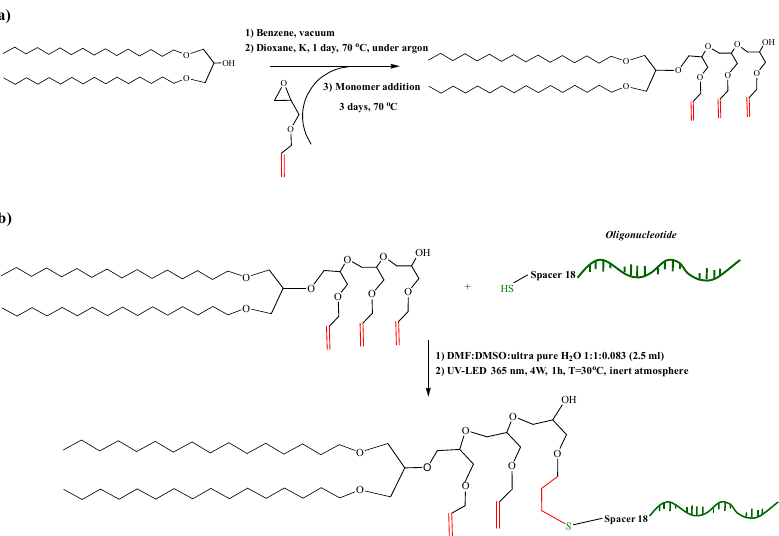
Figure 1. Synthetic schemes for preparation of ( a ) the DHP - (AGE) n intermediate (n = 3) and ( b ) the nucleolipid DHP - (AGE) 3 - oligonucleotide.